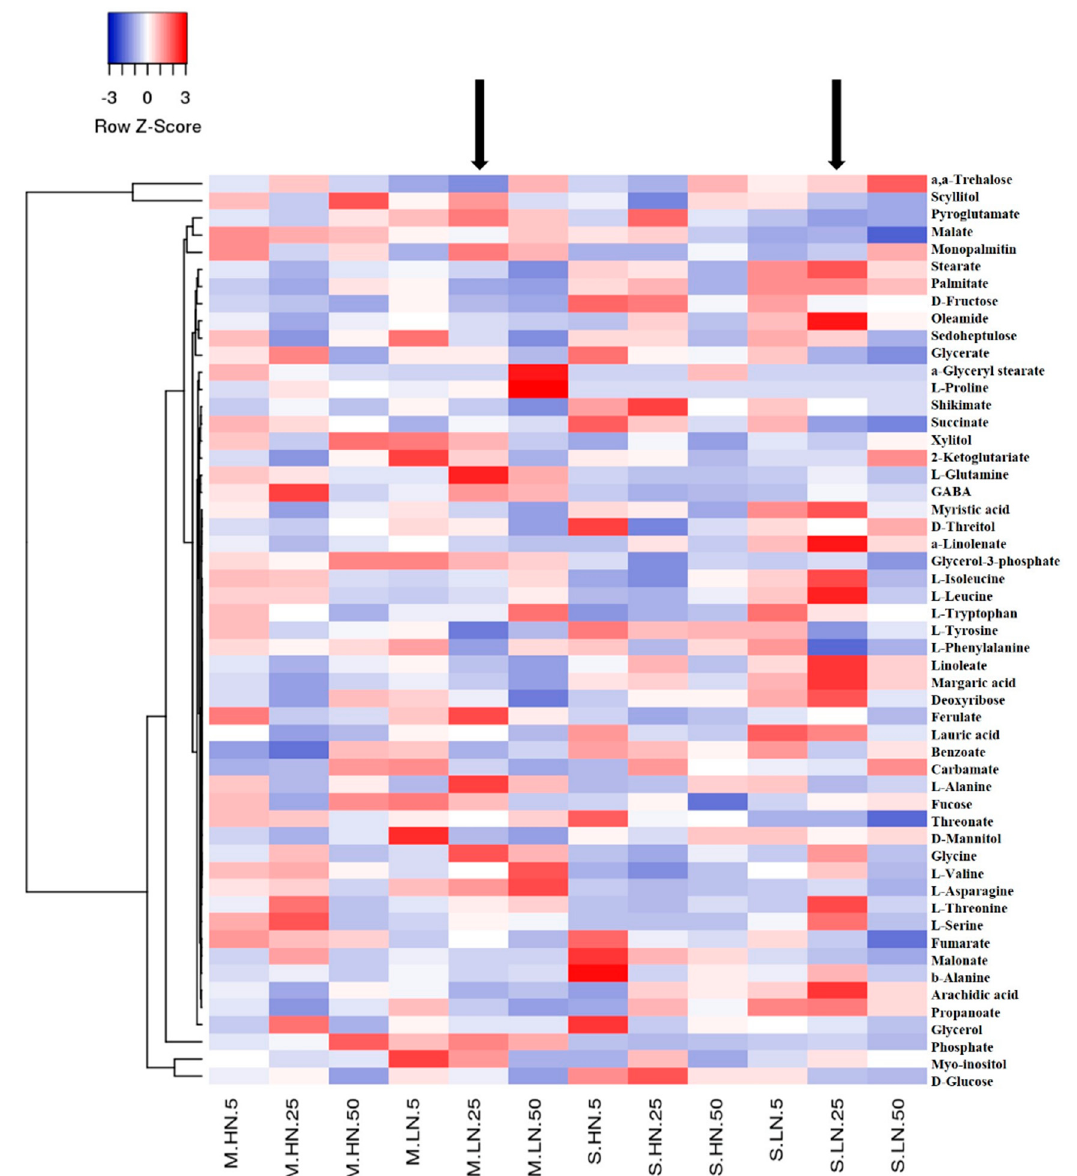
Figure 3. Heat map for the overview of fluctuations in the recorded Cichorium spinosum L. GC/EI/MS leaf metabolome following treatments. Twelve treatments were performed: two contrasting ecotypes; two different total-N levels in the supplied NS, 4 mM as Low-N and 16 mM as High-N; and three NH 4+ /total-N ratios—5%, 25%, and 50%, respectively. Red blocks indicate metabolites that were detected at higher levels, while blue blocks represent the metabolites that were detected at lower levels following treatments. The Heatmapper software [34] was used. Each Heatmap block represents the average value of four replicates.